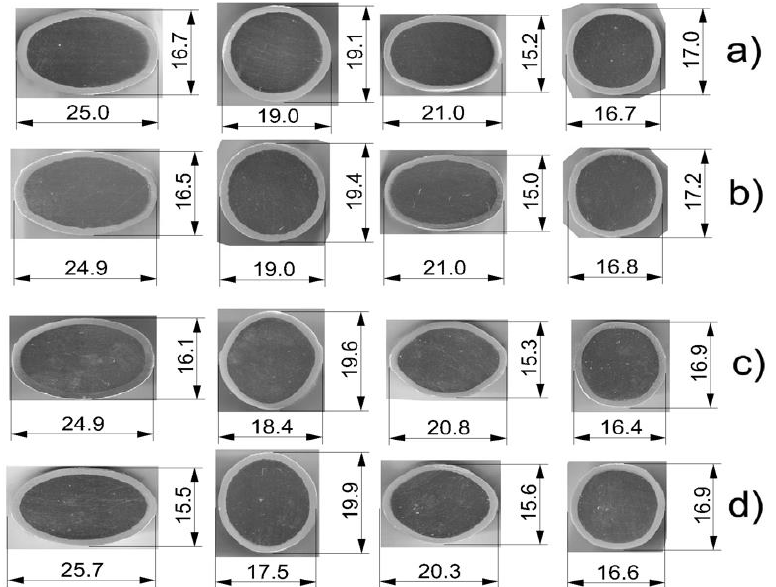
Figure 5. The shape and dimensions of the templets after rolling: ( a ) classic system of passes (var- iant I), rolling temperature of 300 °C; ( b ) classic system of passes (variant I), rolling temperature of 400 °C; ( c ) modified system of passes (variant II), temperature of 300 °C; ( d ) modified system of passes (variant II), temperature of 400 °C.